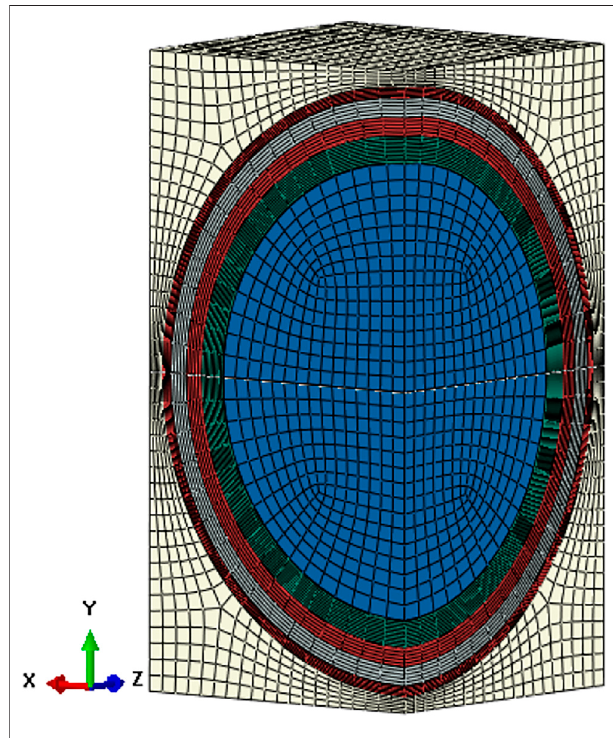
FIGURE 3 | Mesh model of 1/4 RVE of FCM